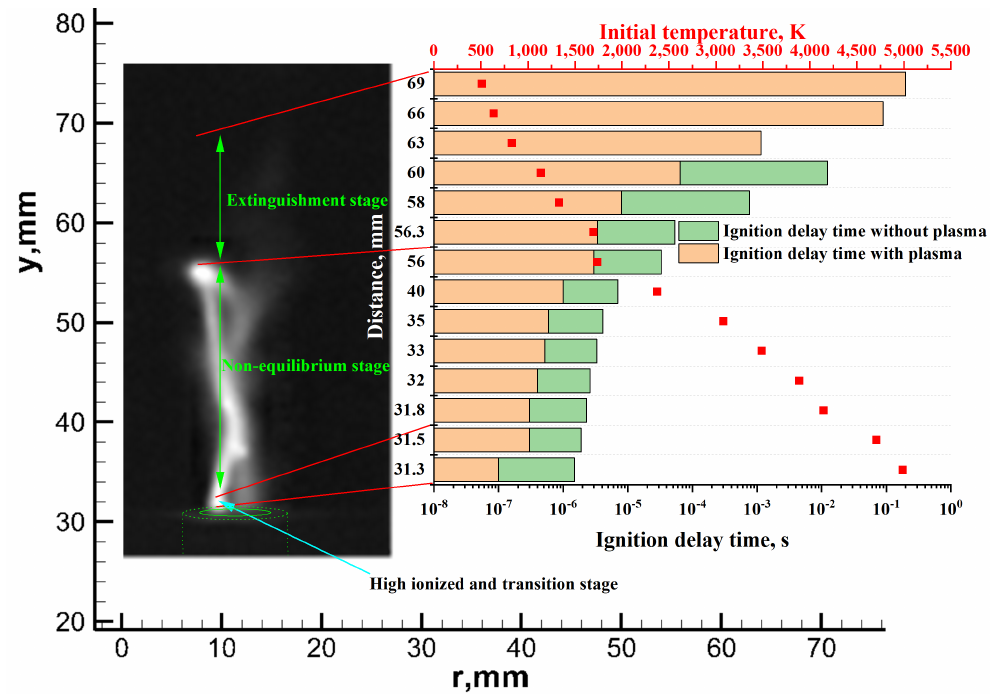
Figure 15. Pentane ignition delay time of the gliding arc in different positions.